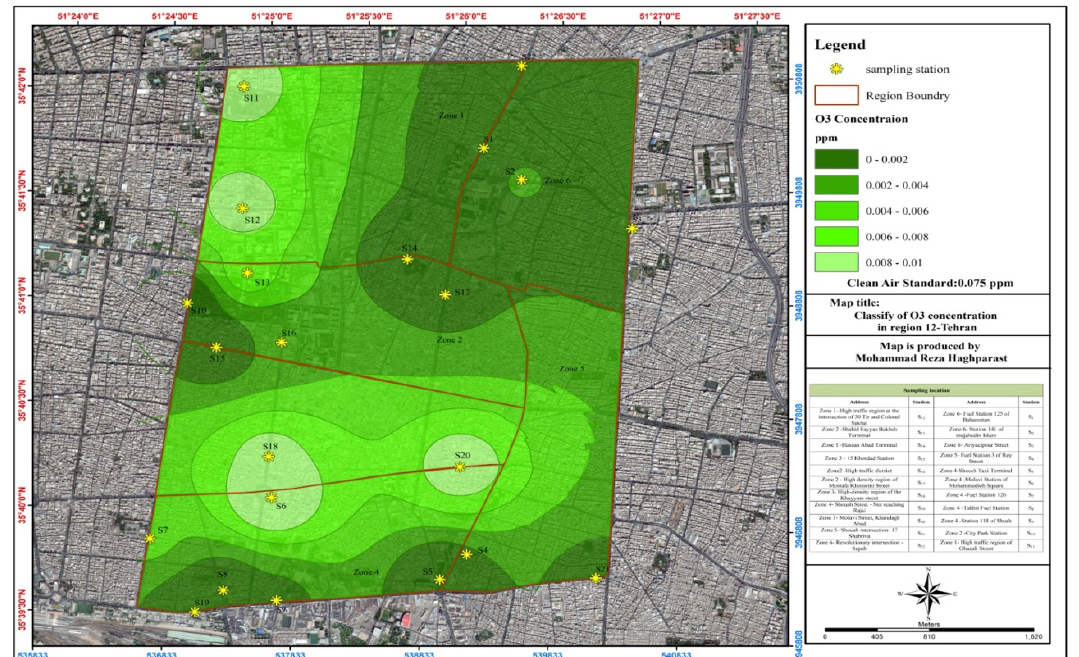
Figure 5. Zoning Ozone concentration in the region on January, 2018 The concentration of this pollutant (PM ) in areas of the zones 3 and 4 was lower than the 10 standard limit and the highest concentrations were observed in zones 6, 1 and 2 mean concentrations are between 33.22 µg/m3 –